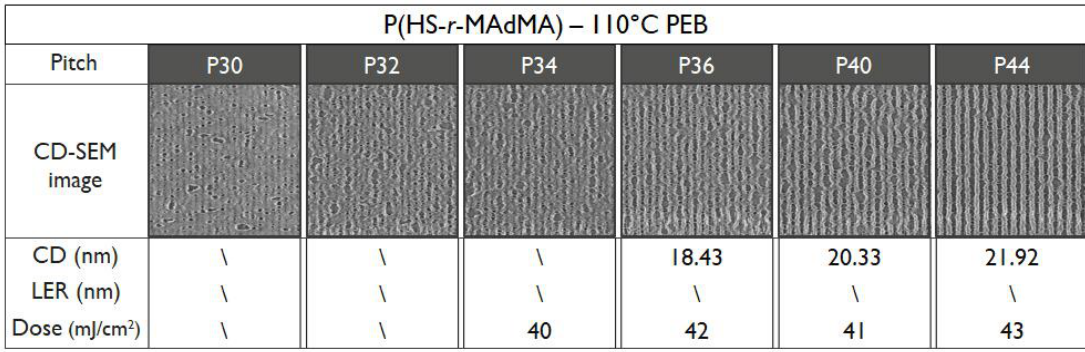
Figure 12. Patterning performance of the P(HS- r -MAdMA) polymer-based resist at 110 °C PEB.